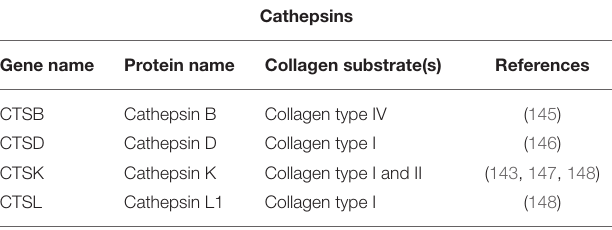
TABLE 1 | Cathepsins and their collagen